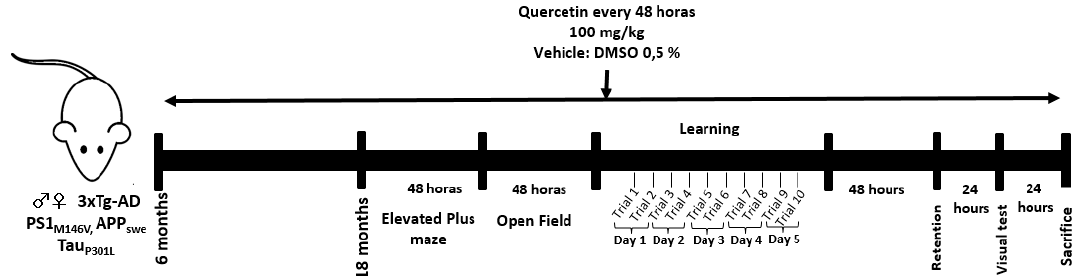
Figure 5. Experimental design of preventive treatment with quercetin.